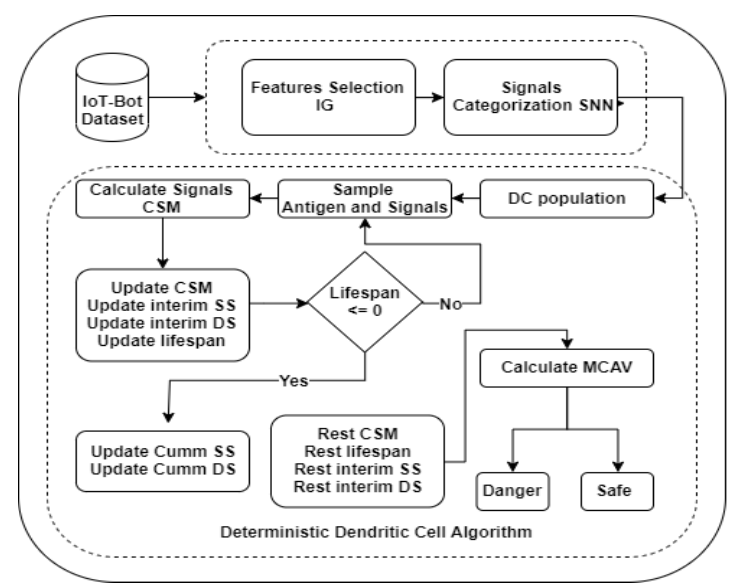
Figure 3. Flowchart of The DeepDCA Proposed